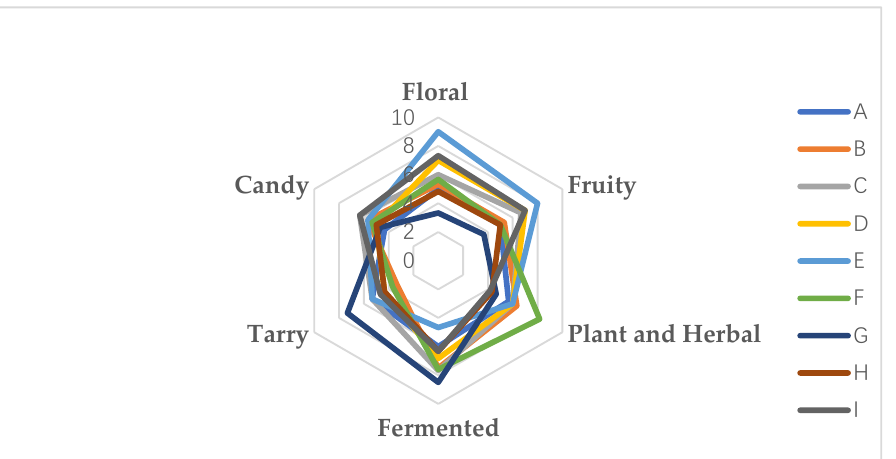
Figure 12. Description of the quantitative aroma analysis of different wine varieties. Note: From A to I are ‘Hassan’, ‘Zuoshaner’, ‘Beibinghong’, ‘Zuoyouhong’, ‘Beta’, ‘Shuanghong’, ‘Zijingganlu’, ‘Cabernet Sauvignon’, and ‘Syrah’.